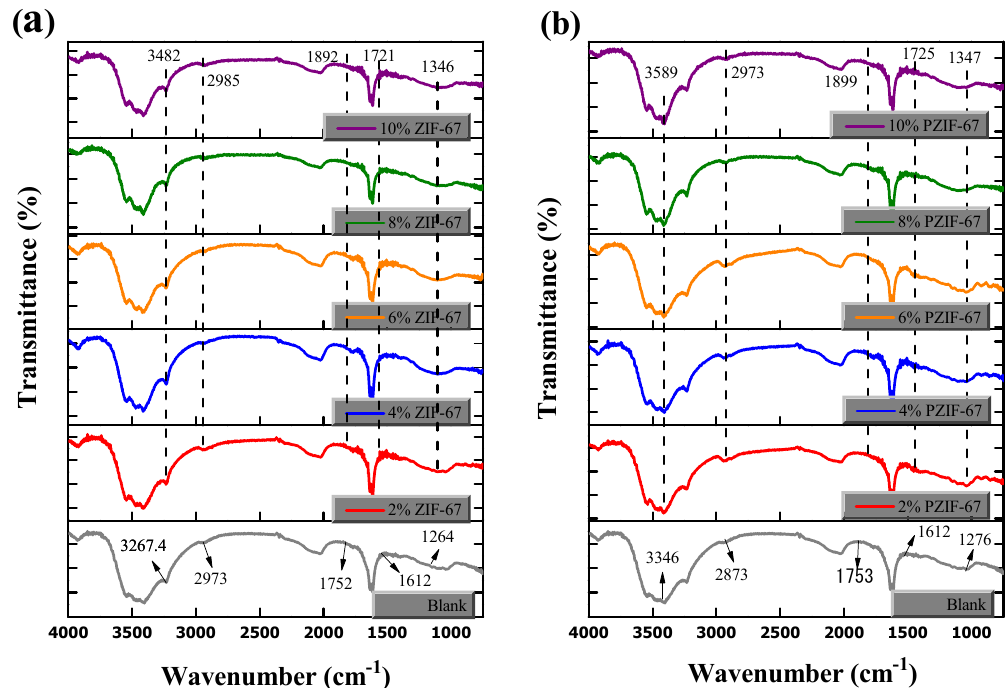
Figure 9. FTIR analysis PVA/starch composite films; ( a ) Containing ZIF-67 and ( b ) Various amounts of Pyrolyzed ZIF-67.